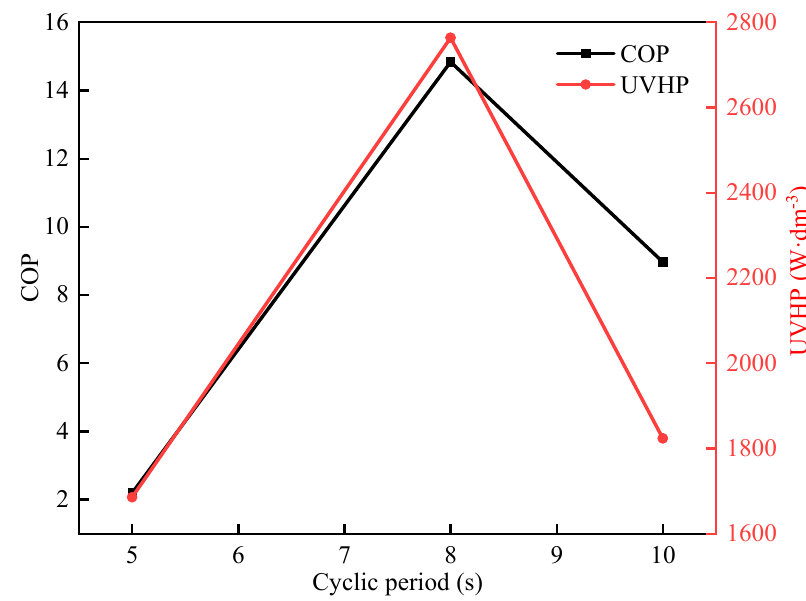
Figure 13. COP and UVHP at different cyclic periods.